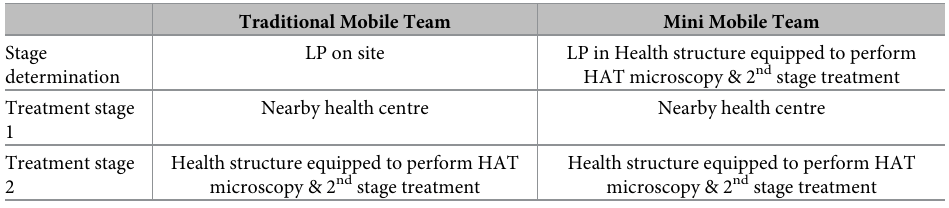
Table 2. Difference in stage determination and